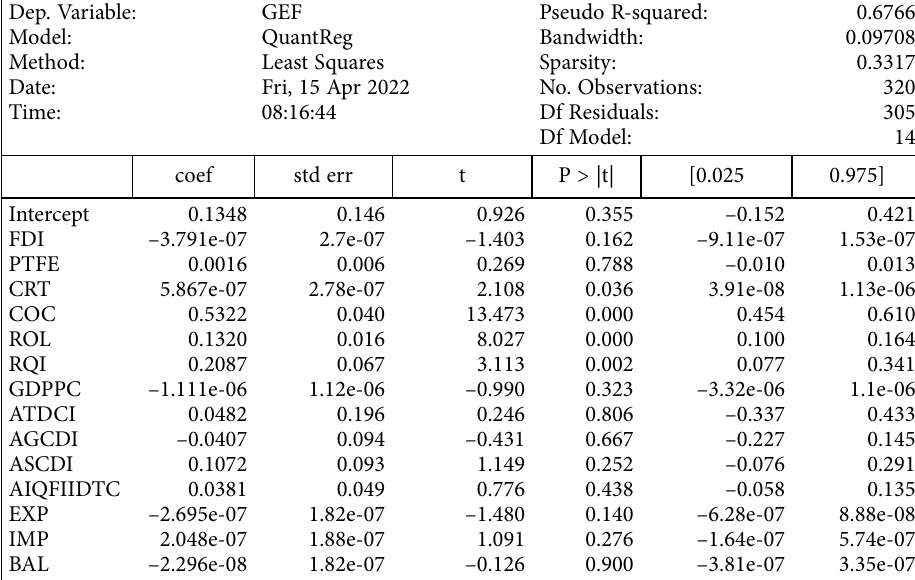
Table 13. QuantReg regression results – Part 3 (source: own processing using Python 3.0